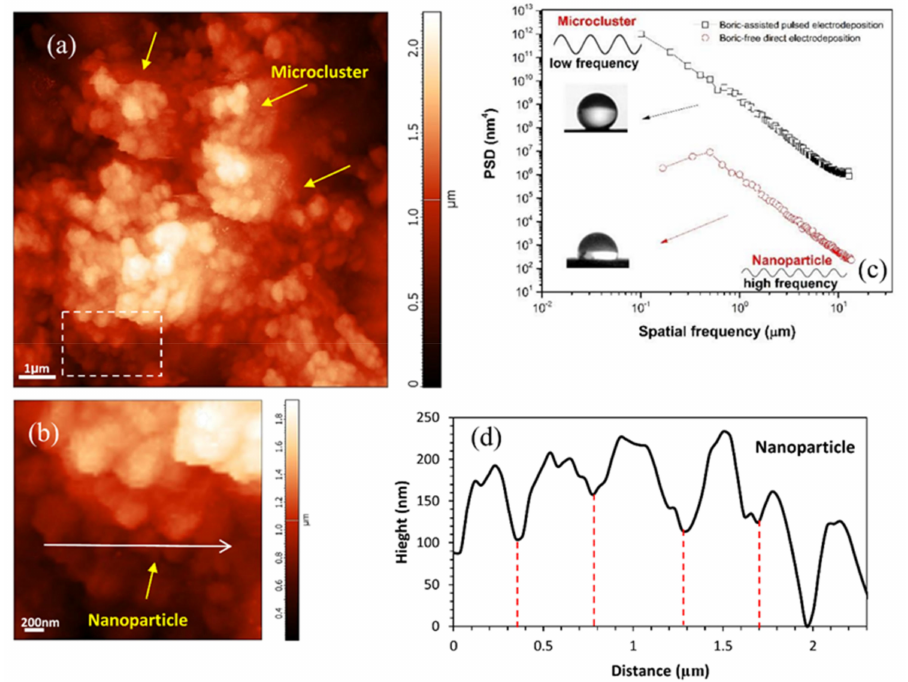
Figure 11. ( a , b ) Atomic force microscopy (AFM) image of microclusters and nanoparticles of superhydrophobic electrodeposited film; ( c ) power spectral density (PSD) versus the spatial frequency for boric-assisted electrodeposited film and boric-assisted direct electrodeposited film; and, ( d )